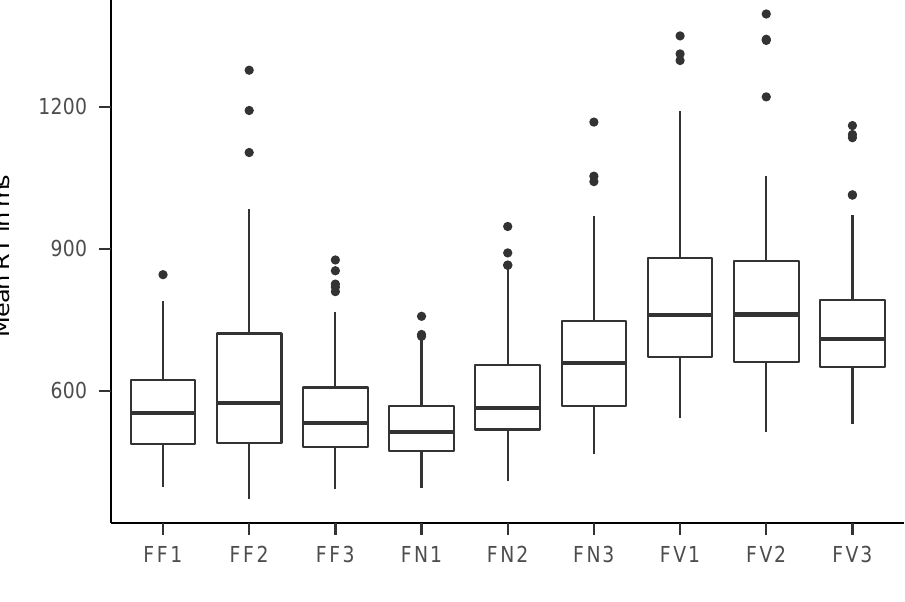
Figure 5. Boxplots of mean response times for all fast tasks. See Table 1 for an explanation of the task names.